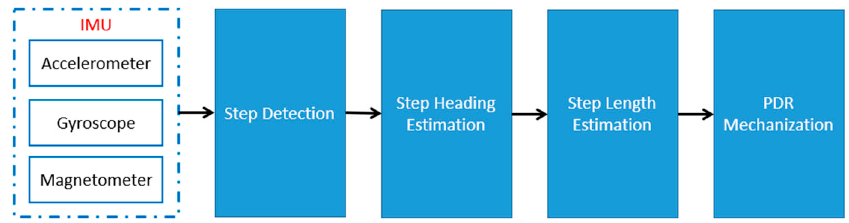
Figure 3. PDR block diagram.